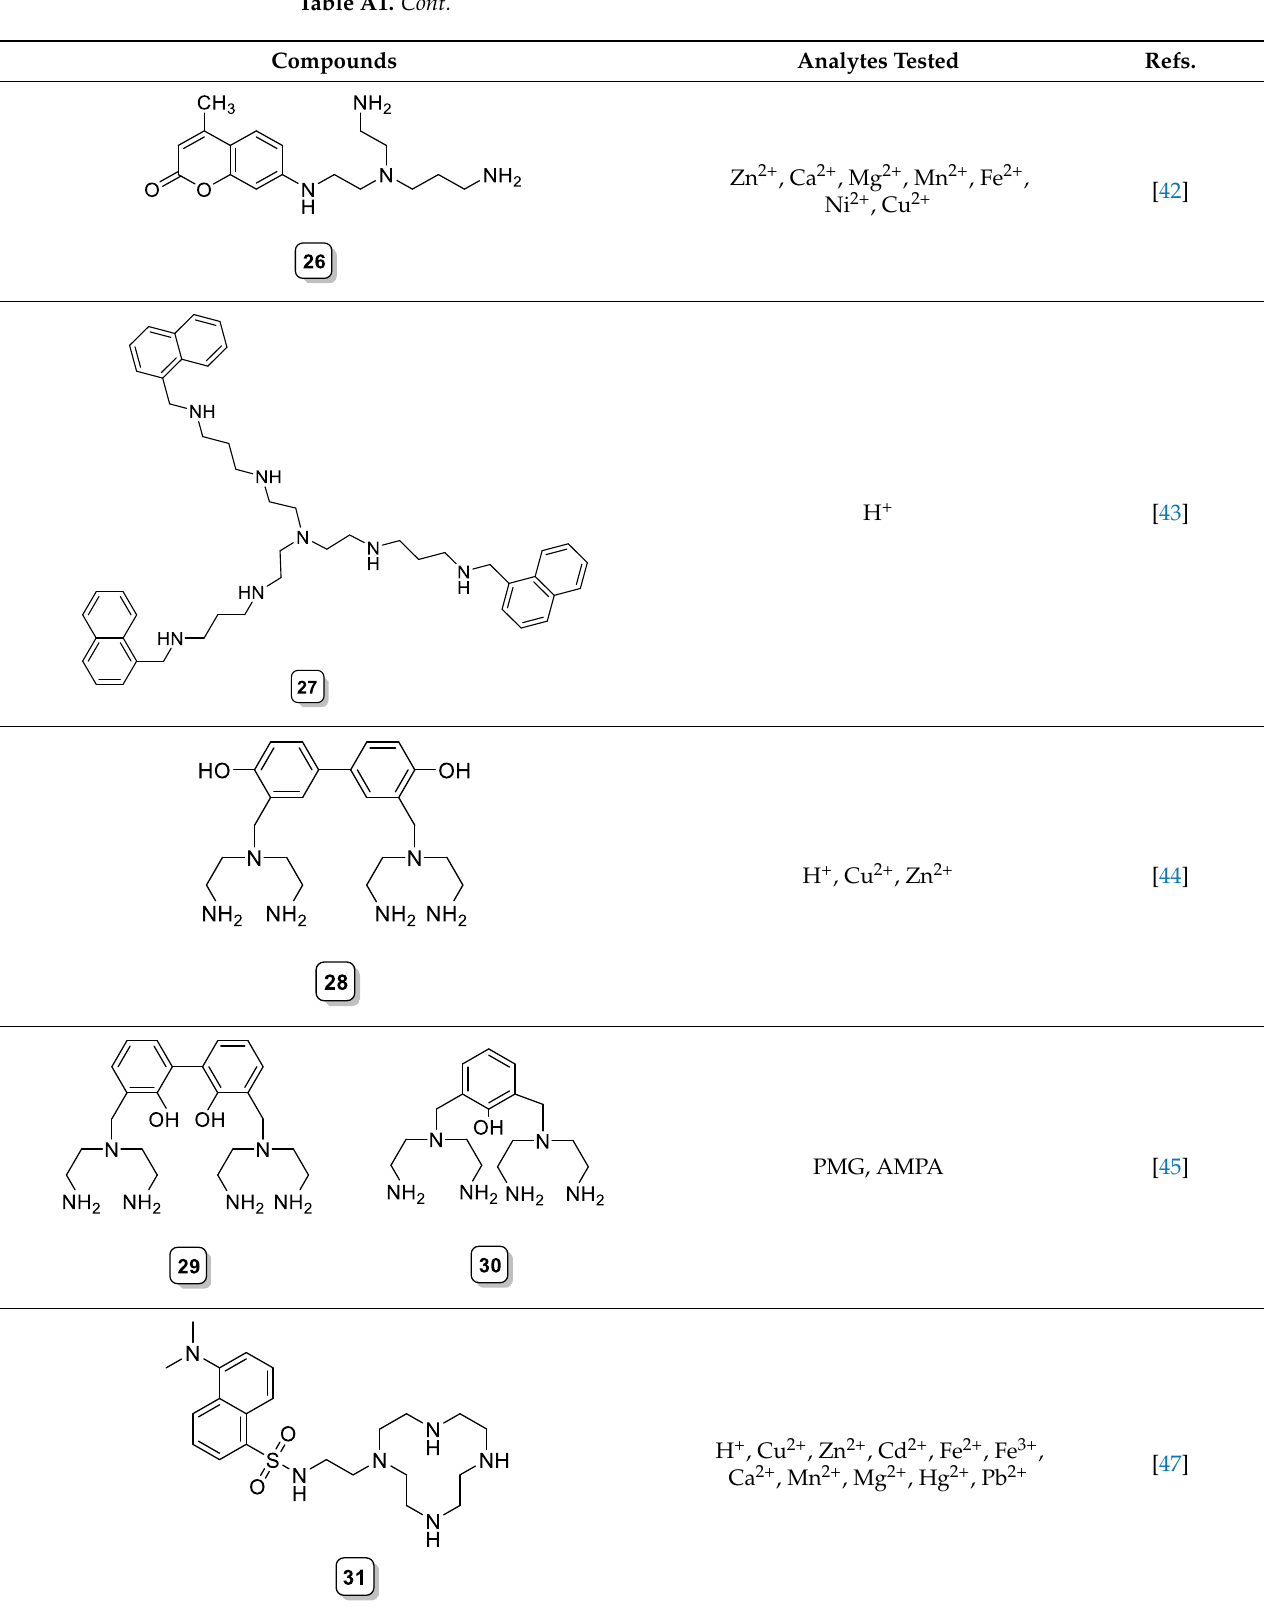
Table A1. Cont. Compounds Analytes Tested